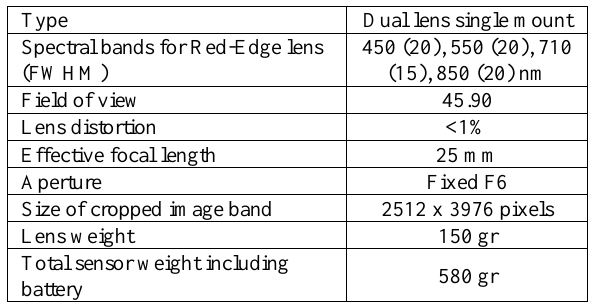
Table 1 . Technical features of Agrowing sensor (Agrowing, 2022).